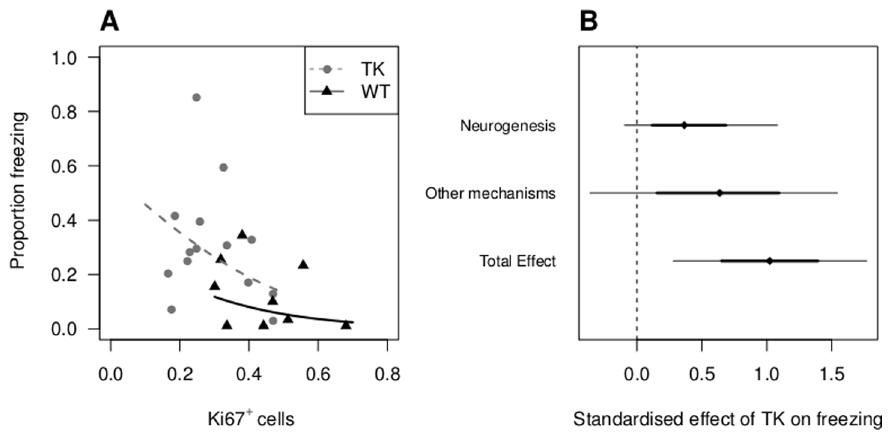
Figure 3. Association between neurogenesis and forgetting. (A) Raw data extracted from Figure 4F in Akers et al. [30] and estimated regression lines. While in the predicted direction (negative association), the relationship is not significant within groups (p 5 0.12). (B) The causal mediation analysis divides the total effect of the TK transgene into the part that can be attributed to neurogenesis and to all other mechanisms. The effect of neurogenesis accounted for less than half (40%) of the total effect, although there is a great deal of uncertainty in this estimate. Error bars are 95% (thin) and 50% (thick) credible